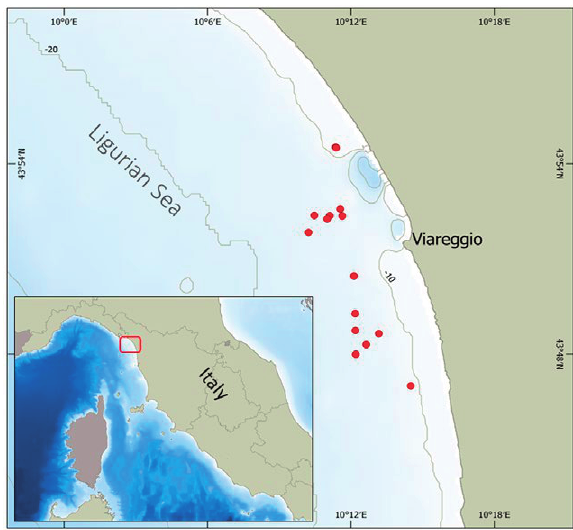
Fig. 1. – Map of the sampling area. Red circles represent the posi- tion of the experimental hauls.